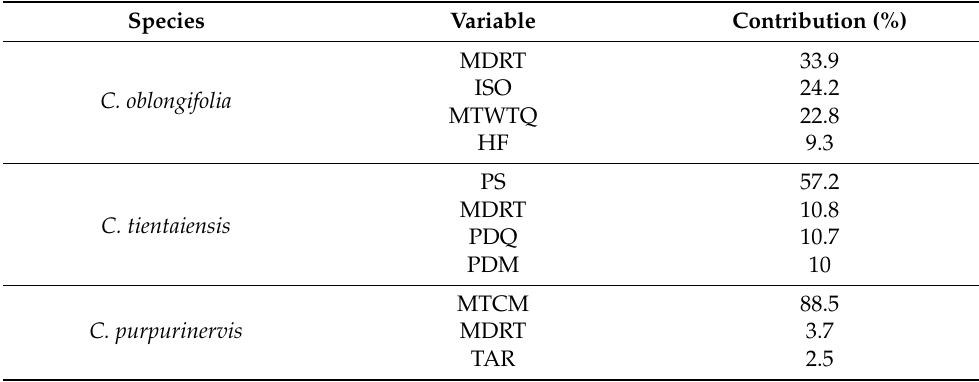
Table 3. Contributions of the most influencing environmental variables to each model.